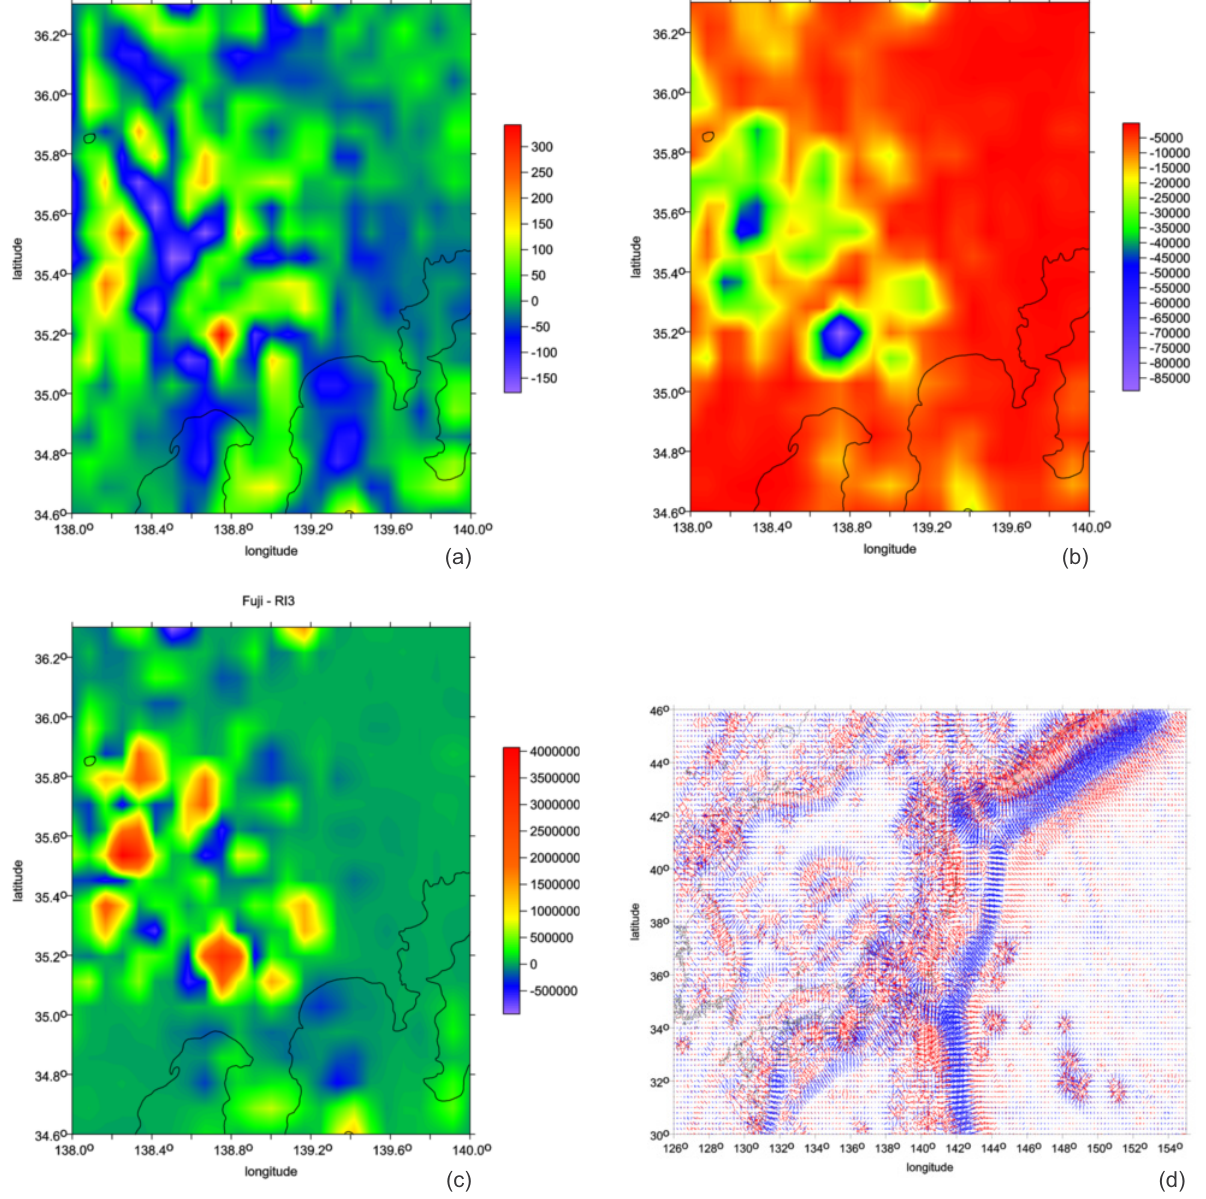
Figure 3. The gravitational signal of a volcano - type example. (a) The radial derivative T invariants I , I around Fuji; (d) the virtual deformations over Japan, at a close trench in the Pacific ocean and undersea volcanoes; com- 1 2 puted with EGM 2008 till degree and order 2190. Reproduced from Kloko č ník et al.